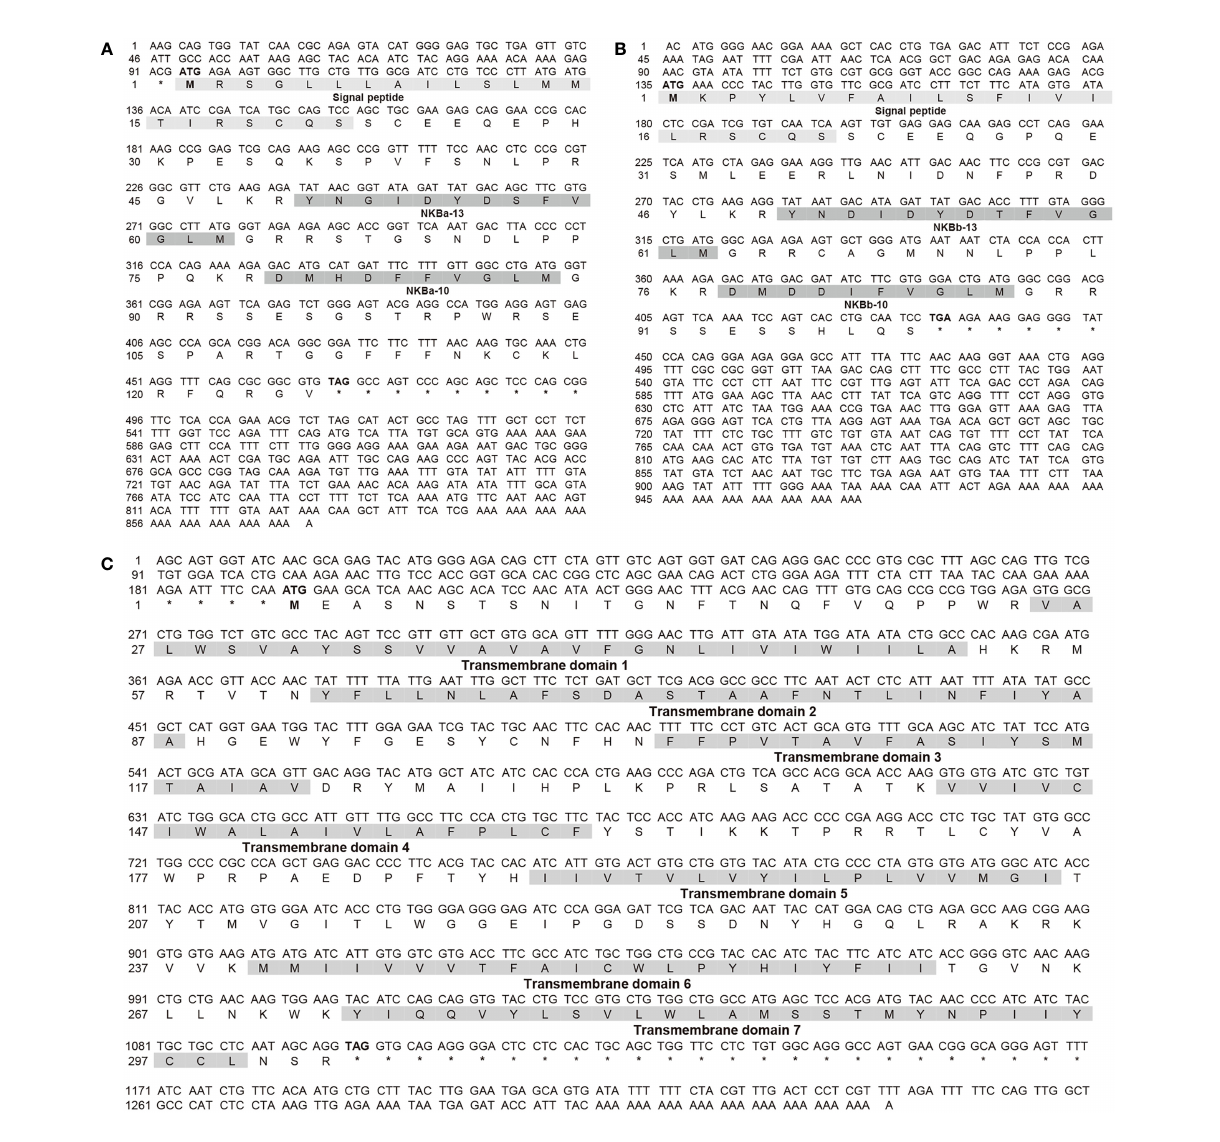
FIGURE 1 | Nucleotide sequences and deduced amino acid sequences of tac3a (A) and tac3b (B) in Japanese eel. The signal peptides and NKB peptides were shaded, and their names under the corresponding sequence. Nucleotide sequences and deduced amino acid sequences of tacr3 (C) in Japanese eel. The transmembrane domains were numbered under the corresponding sequence, and their sequence compositions are